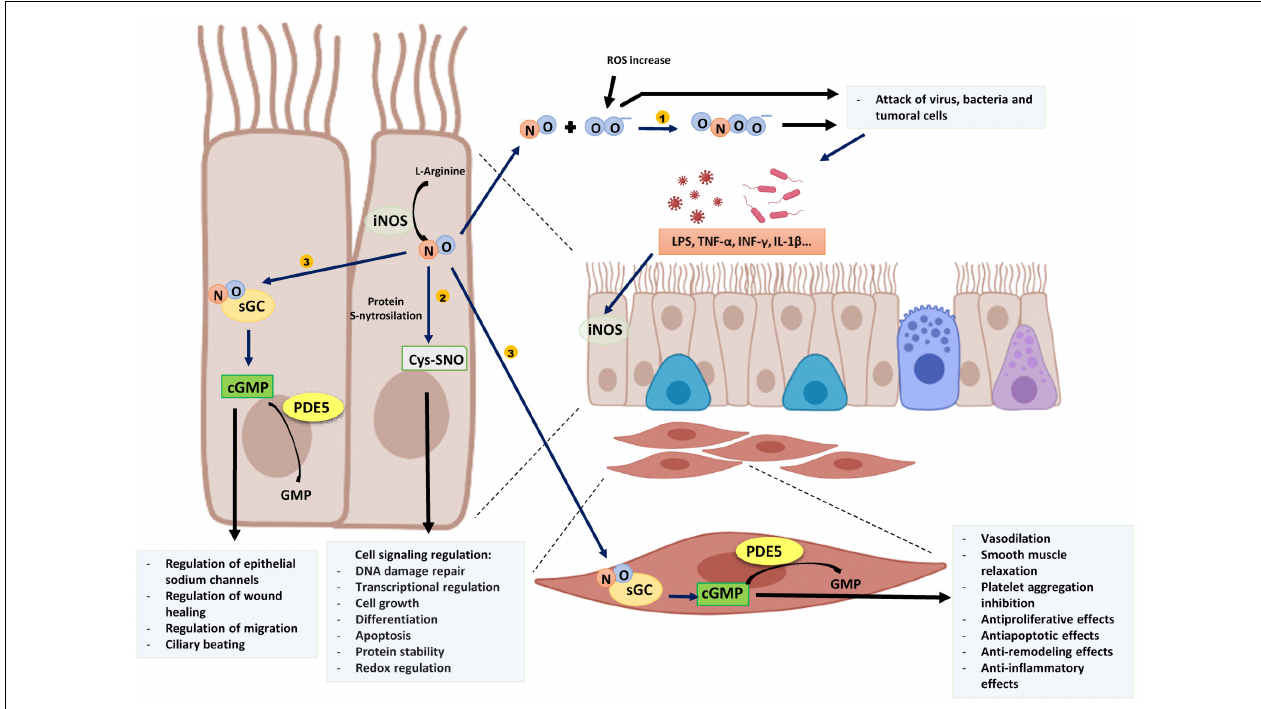
FIGURE 1 | Proinflammatory stimuli and cytokines induce epithelial iNOS expression producing an increase of NO. (1) NO reacts with superoxide (O 2 − ) and generates peroxynitrite (ONOO − ) that, with other ROS damage tumoral cells and several intracellular organelles of pathogens. (2) NO is involved in several cell signaling pathways by protein S-nitrosylation. (3) NO binds to sGC of epithelial cells or other target cells such as muscle cells and produces cGMP. PDE5 degrades cGMP into GMP. The image has been created with Biorender.